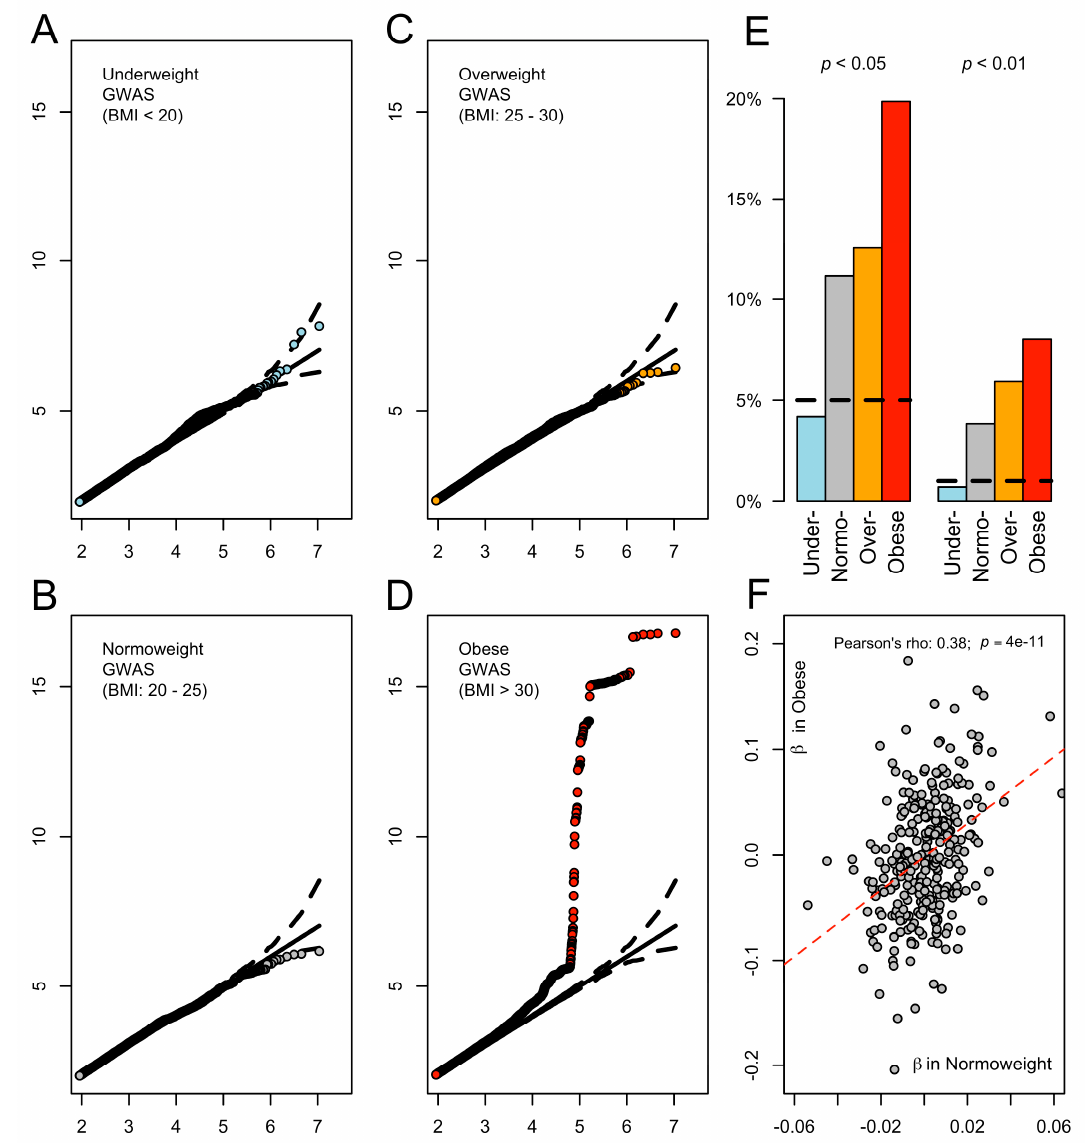
Figure 1. The genetic control of body mass index (BMI) differs across body fat categories. ( A – D ) Q-Q plots depicting genome-wide association results for stratified-genome-wide association studies (GWAS) for each BMI category. Y -axis displays the -log 10 of the p -value of association derived from linear regression (see Methods Section 2.2 Stratified GWAS ). ( E ) Barplots showing the percentage of the 283 BMI-associated single nucleotide polymorphisms (SNPs) (see Methods Section 2.3 Calculation of Genetic Risk Scores ) that pass nominal significance ( p < 0.05 and p < 0.01 are depicted). With the exception of the underweight sub-group, all the other three BMI subgroups harbor an excess of positive replications of the GIANT signals, implying an excess of real effects. The horizontal dashed line corresponds to random expectation. ( F ) Scatterplot of the β in normoweight and obese subgroups for the same